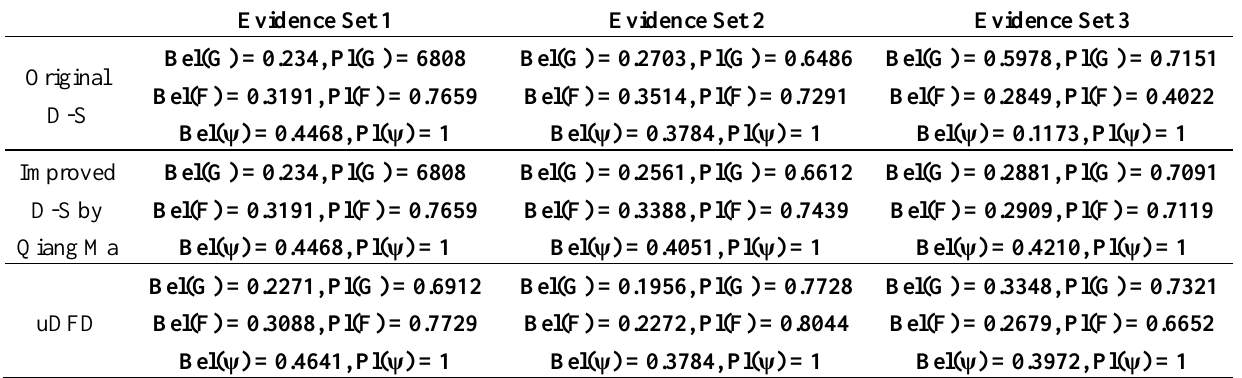
Table 2. Belief functions and plausibility functions of fusion